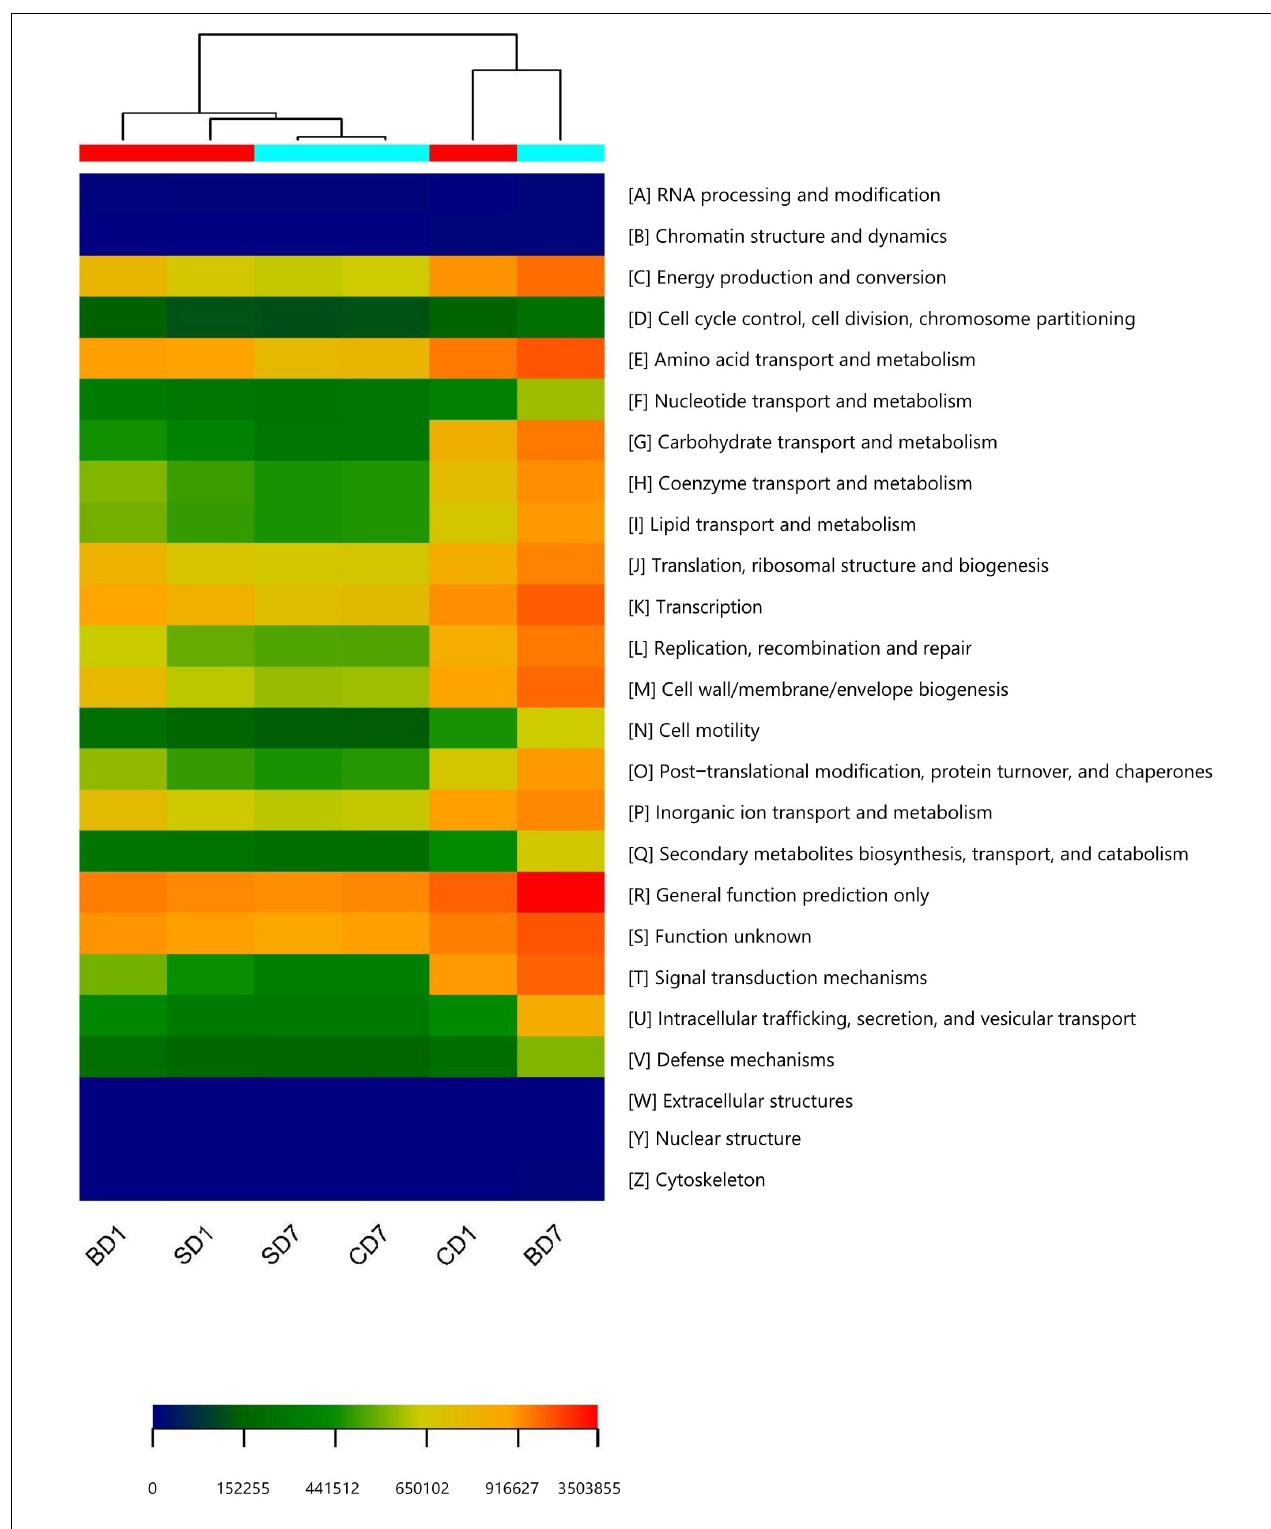
FIGURE 4 | Heat map of predicted functions based on COG analysis with PICRUSt. The predictions have 95% probabilities in truly reflecting the real functions of a gut microbiota ( p < 0.05). The heat map was drawn with the gplots package in R software. Different colors represent the extent of strength/richness of a function with a darker red color representing stronger strength (higher richness) and darker blue representing lower richness. BD1, SD1, and CD1 represent PL samples at day 1 of the test, and BD7, SD7, and CD7 represent PL samples at day 7.